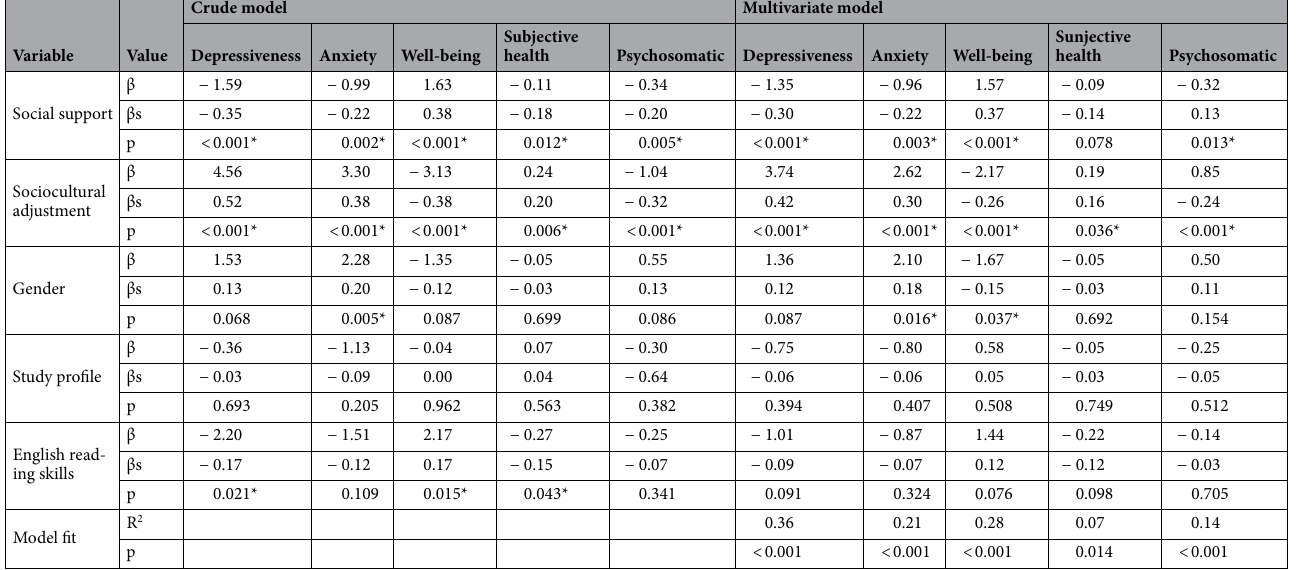
Table 6. The role of sociocultural adjustment and social support on mental health: linear regression analysis. *p <